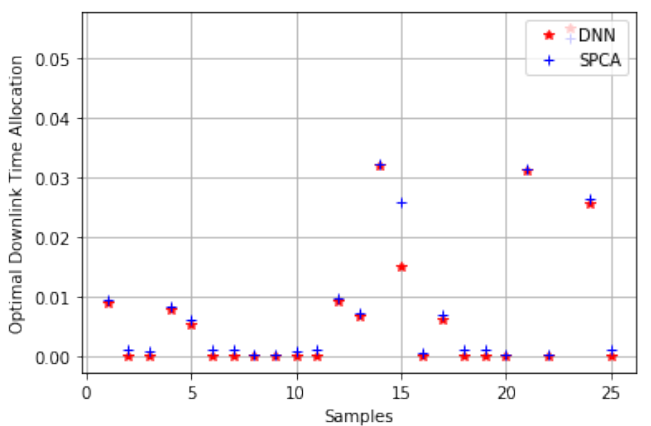
Figure 5. Optimal downlink time allocation samples from the DNN and SPCA.